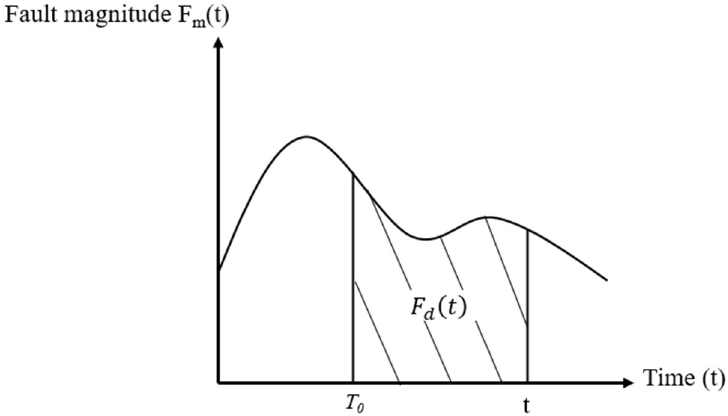
Figure 2. Fault degree F d computation.